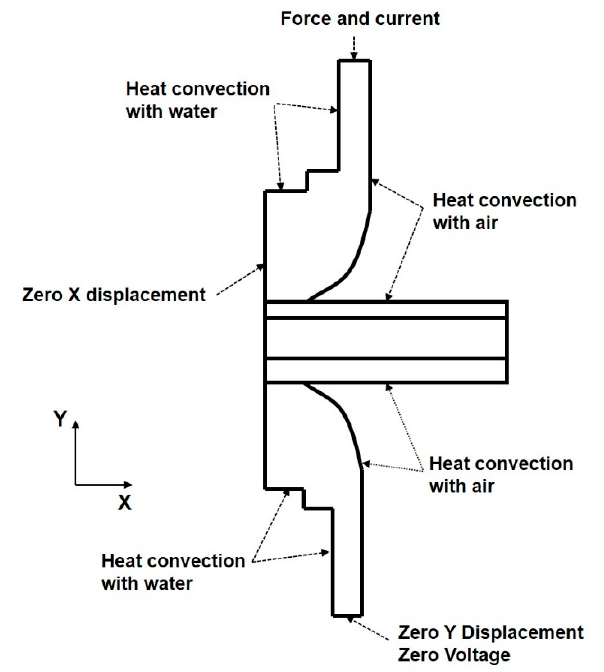
Figure 5. Boundary condition for modeling the weld-bonding process.